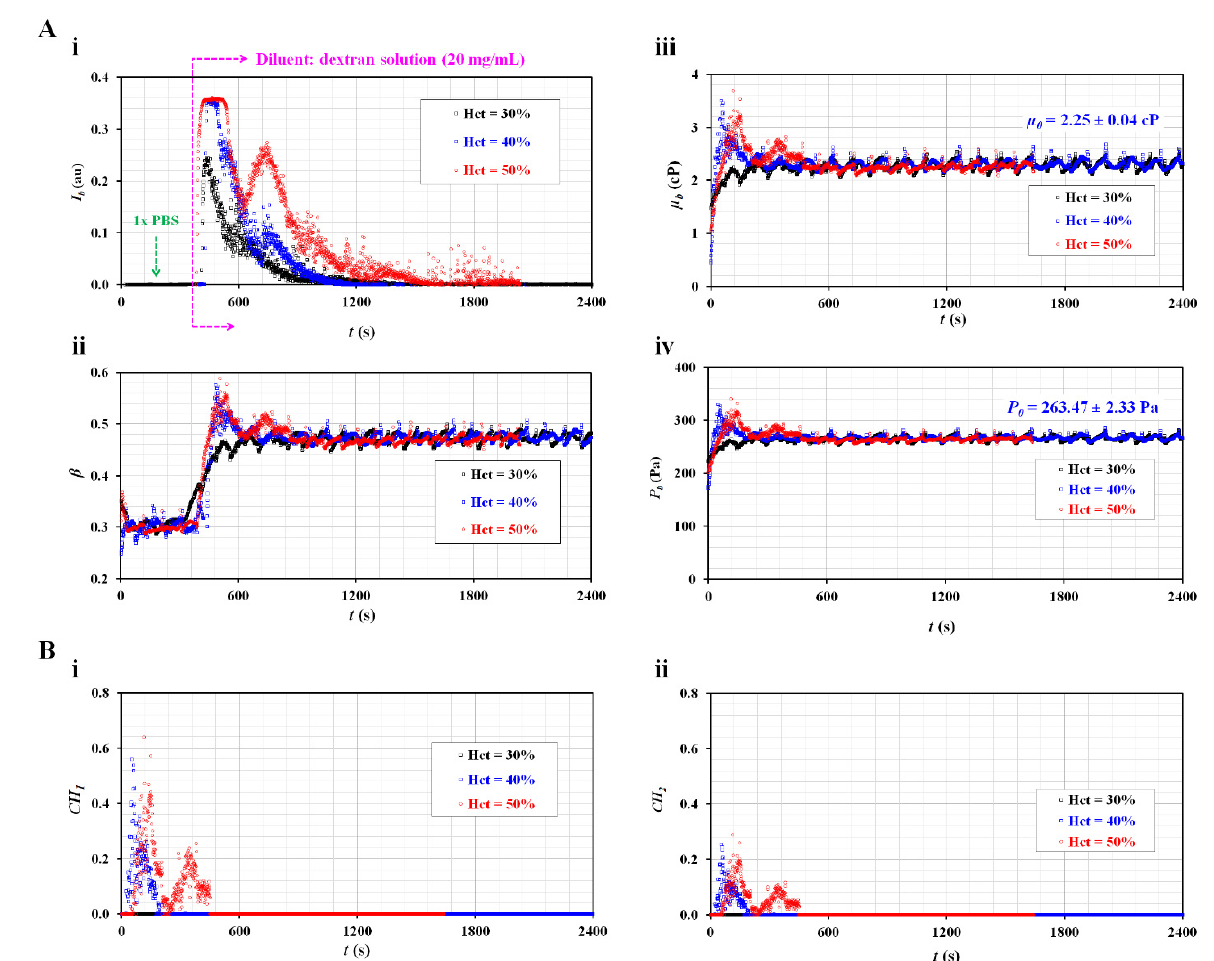
Figure 4. Quantitative evaluations of the effect of RBC sedimentation for maximum RBC aggregation-enhanced blood. The hematocrit was set at Hct = 30%, 40%, and 50% by adding normal RBCs into a dextran solution (20 mg/mL). ( A ) Temporal variations in image intensity and interface with respect to hematocrit. ( A - i ) Temporal variations in I b with respect to Hct. ( A - ii ) Temporal variations in β with respect to Hct. ( A - iii ) Temporal variations in µ b with respect to Hct. The viscosity of the diluent was µ 0 = 2.25 ± 0.04 cP. ( A - iv ) Temporal variations in P b with respect to Hct. The junction pressure of the diluent was P 0 = 263.47 ± 2.33 Pa. ( B ) The contributions of RBC sedimentation to the physical properties of blood (blood viscosity and junction pressure). ( B - i ) Temporal variations in CH 1 with respect to Hct. ( B - ii ) Temporal variations in CH 2 with respect to Hct.